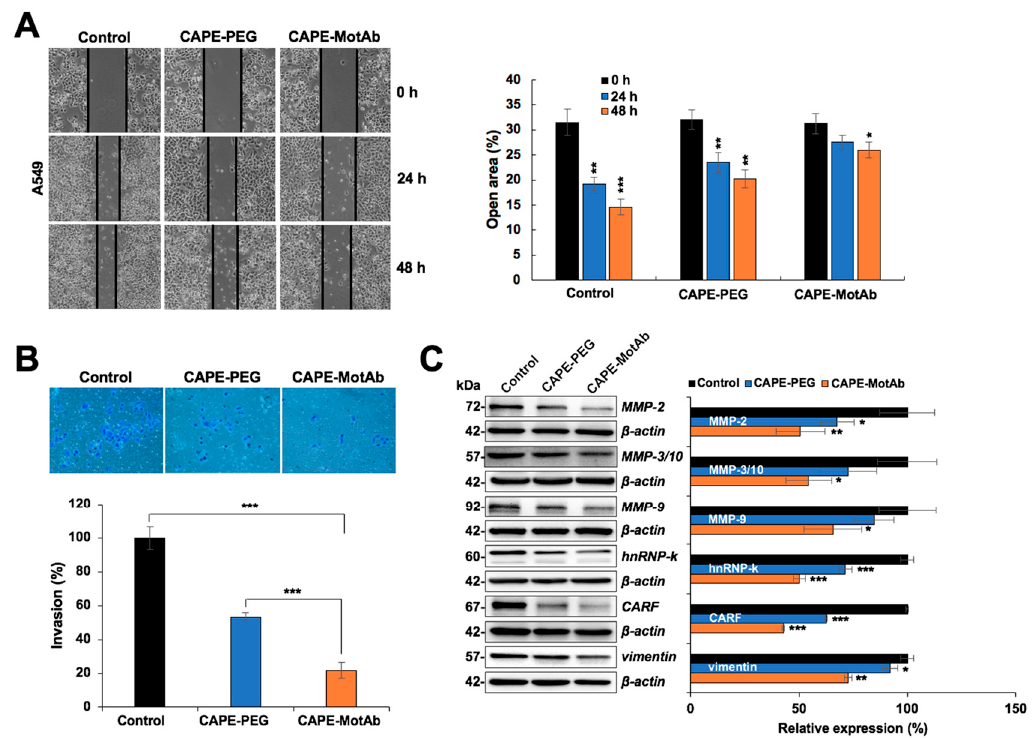
Figure 6. CAPE-MotAb possesses enhanced anti-migration and anti-invasion activity. ( A ) Wound scratch assay showing that CAPE-MotAb treated A549 cells moved slower when compared to the other two groups as indicated in the open area of the wound (CAPE concentration: 5 μ g/mL). Quantitation of the open area from three independent experiments (mean ± SD, n = 3), * p < 0.05, ** p < 0.01, *** p < 0.001 (Student’s t-test to control). ( B ) Representative images of the invasion assay exhibiting impaired invasion in CAPE-MotAb treated A549 cells. Quantitation of cell invasion results from three independent experiments (mean ± SD, n = 3), *** p < 0.001 (Student’s t-test). A549 cells were treated with an equivalent dose of CAPE (10 μ g/mL) for 24 h. ( C ) Western blot analysis for metastasis-associated proteins (MMP2, MMP3, MMP9, hnRNP-k, CARF, and Vimentin) after 48 h incubation of cells with CAPE-MotAb (10 μ g/mL). Quantitation of the results is shown on the right (mean ± SD, n = 3), * p < 0.05, ** p < 0.01, *** p < 0.001 (Student’s t-test to control).